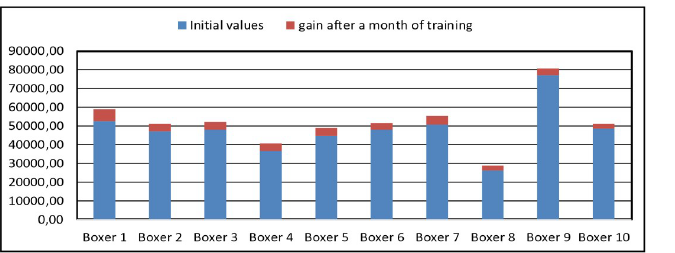
Fig 11. A graph of the punch quality, group